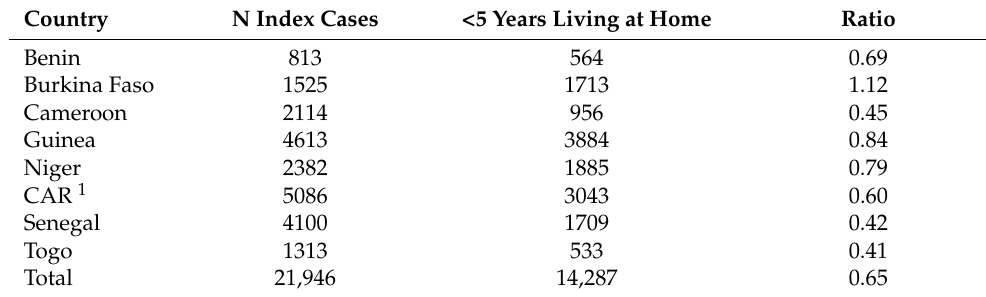
Table 4. Ratio of the number of children under five years living at home to the number of index